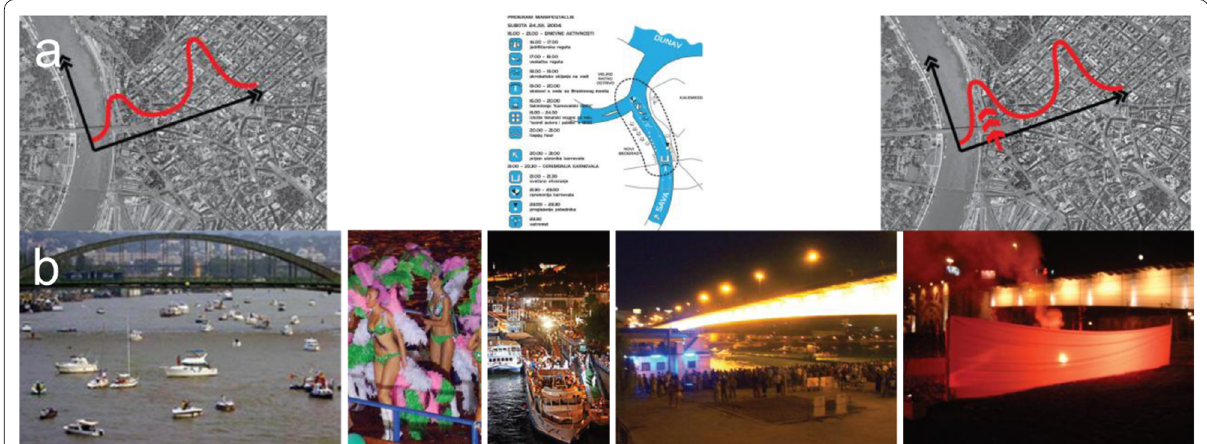
Fig. 8 Belgrade Boat Carnival by PaPs (2004); a public art strategy and program; b realization of the project